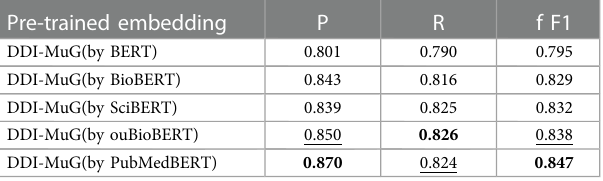
TABLE 4 The effect of pre-trained embedding. The highest value is labelled in bold. Pre-trained embedding